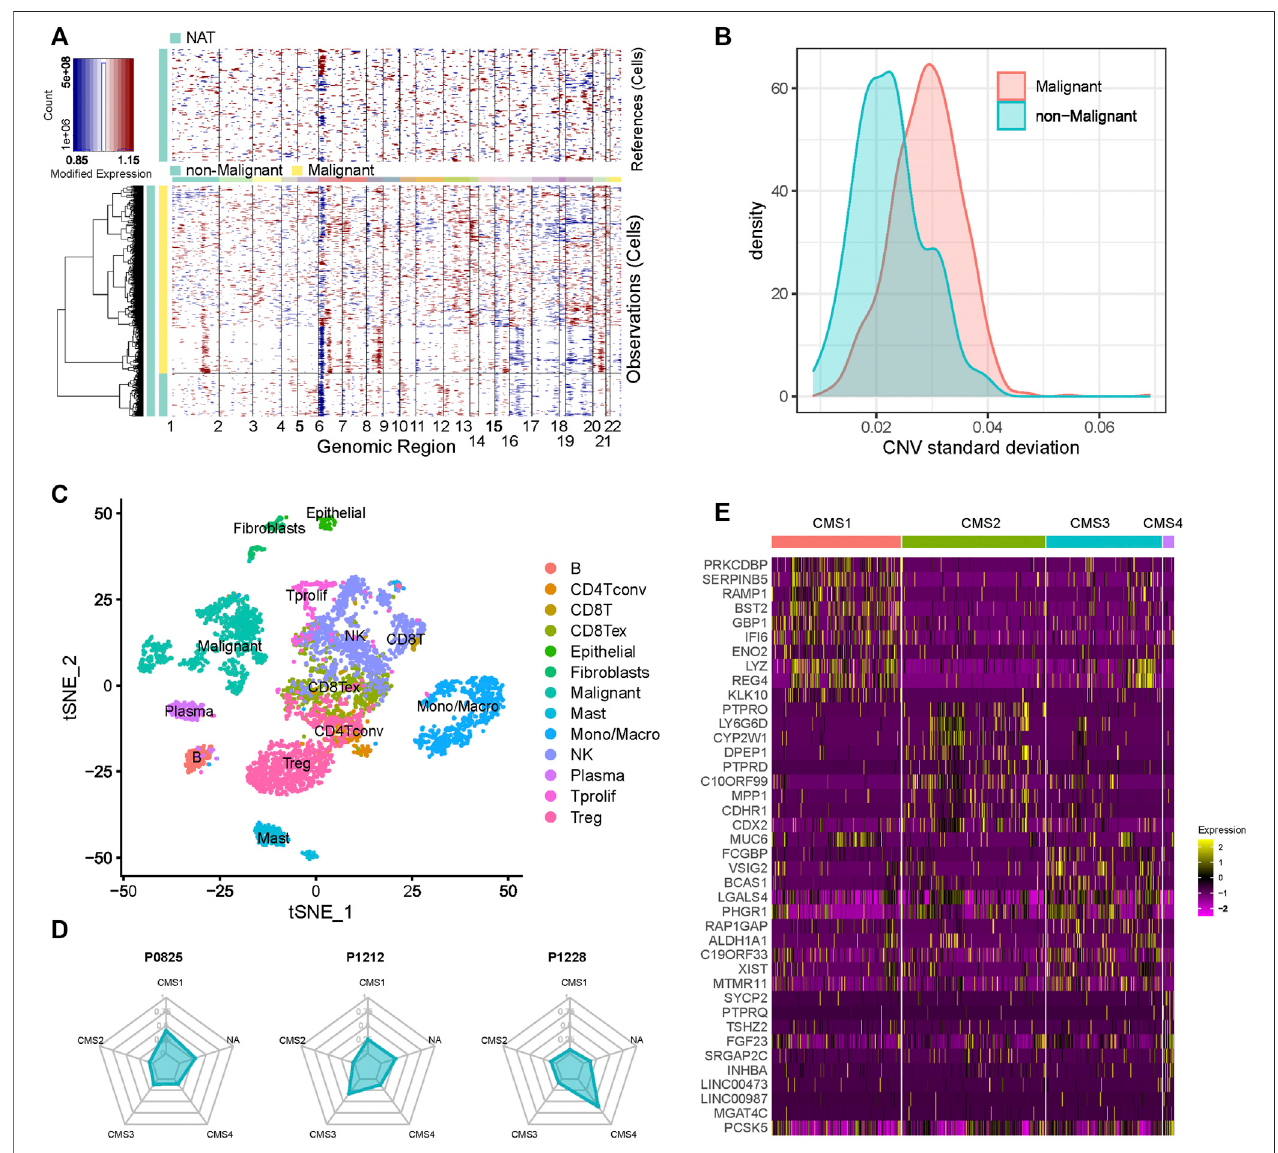
FIGURE1| CellcompositionofCRCpatients (A) Heatmap oftheinferredCNVs across1,123epithelialcells (B) StandarddeviationoftheCNVsofthecellsineach cluster (C) t-SNE plot of the scRNA-seq data (D) CMS composition of each CRC patient (E) Heatmap of the markers ’ expression in each subgroup.